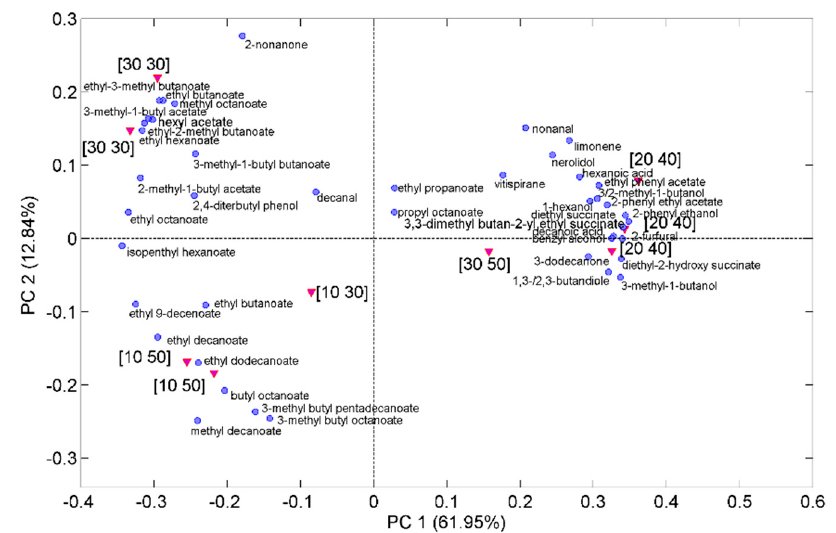
Figure 7. Scores (red triangles) and loadings (blue circles) projected on the plane of the first two principal components (PC1 and PC2) extracted from the GC chromatograms collected with the DVB/CAR/PDMS fiber in the DOE points. Experimental conditions of the DOE points are identified by %NaCl and T values reported in square brackets.